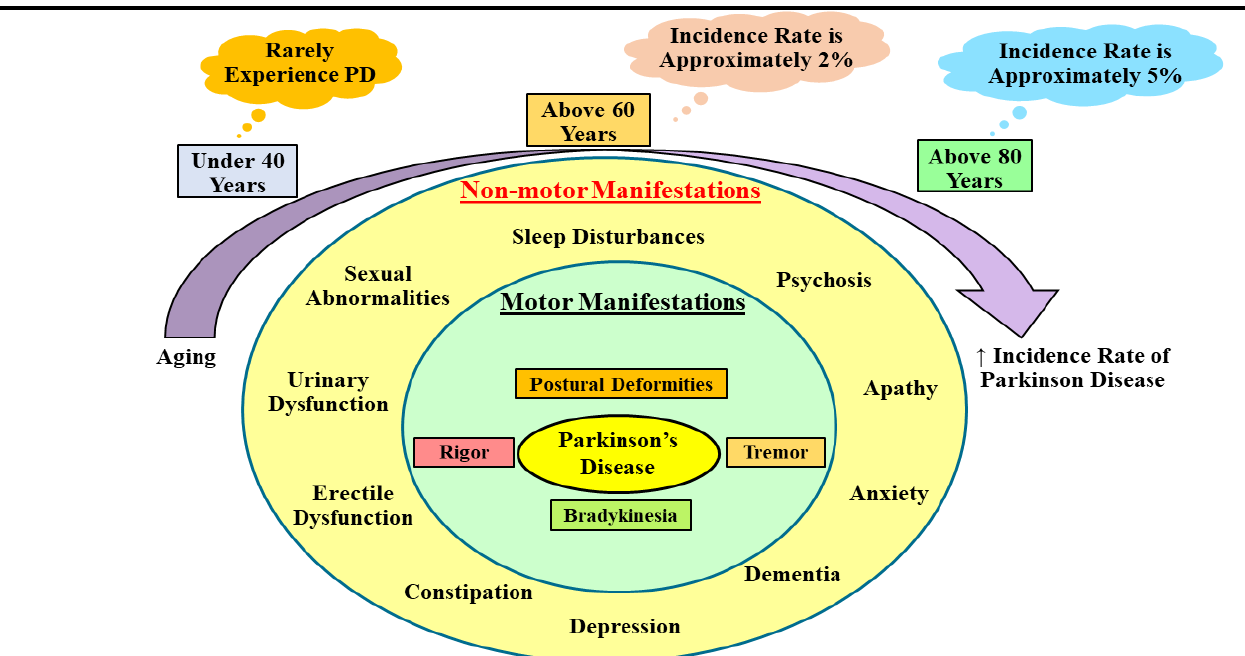
Figure 1. The diagram illustrates the expansion in the incidence rate of Parkinson’s disease with aging, and also outlines the motor and nonmotor manifestations associated with Parkinson’s disease. Aging is reckoned as the critical parameter actively engaged in the evolution of PD. The incidence rate of PD escalates with aging, i.e., people ranging under 30–40 years rarely experience PD, 2% of people ranging above 60–70 years experience PD, and 5% of people ranging above 80–90 years experience PD. The motor manifestations of the disease comprehends rigor, postural deformities, tremor, and bradykinesia. On the other hand, the nonmotor manifestations associated with the disease comprehends urinary dysfunction, sexual abnormalities, sleep disturbances, psychosis, dementia, anxiety, apathy, depression, constipation, and erectile dysfunction. Howbeit, the nonmotor manifestations are comparably less noticeable than motor manifestations. PD, Parkinson’s disease; ↑ , increasing.